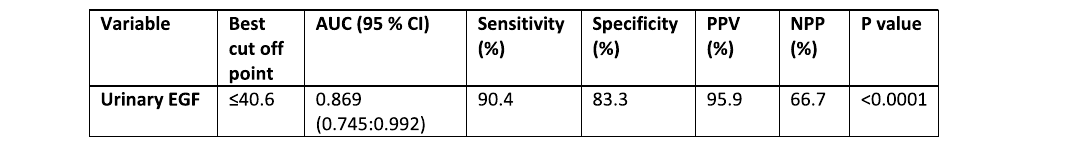
Fig. 3 ROC curve analysis of urinary EGF in relation with the histological renal